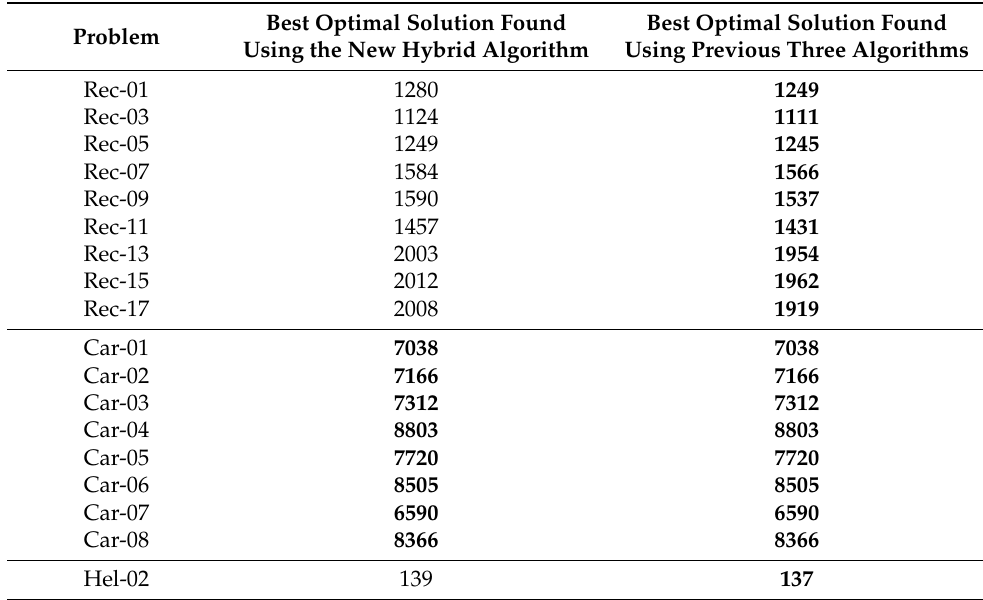
Table 6. Comparison of the best optimal solution found using the new hybrid algorithm and the previous three algorithms.